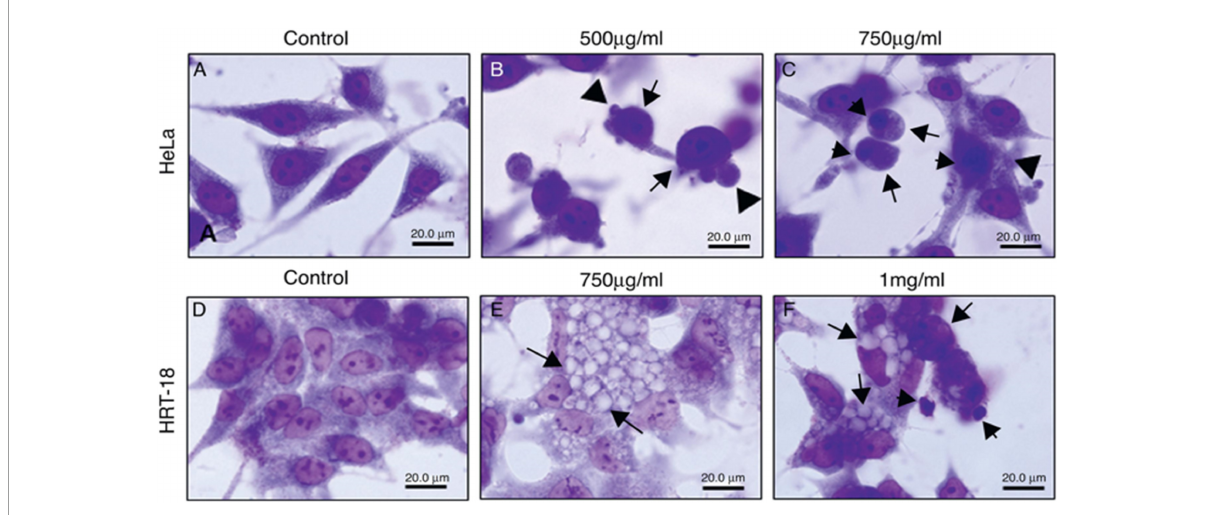
FIGURE16 Morphological changes of HeLa and HRT-18 cells under treatment with latex of E. umbellata (Pax) Bruyn (A,D) controls; cells incubated with RPMI only. (B) HeLa cells incubated with 500 and (C) 750 µ g/ml of latex. (E) HRT cells incubated with 750 µ g/ml and (F) 1,000 µ g/ml of latex ( Luz et al., 2015 )